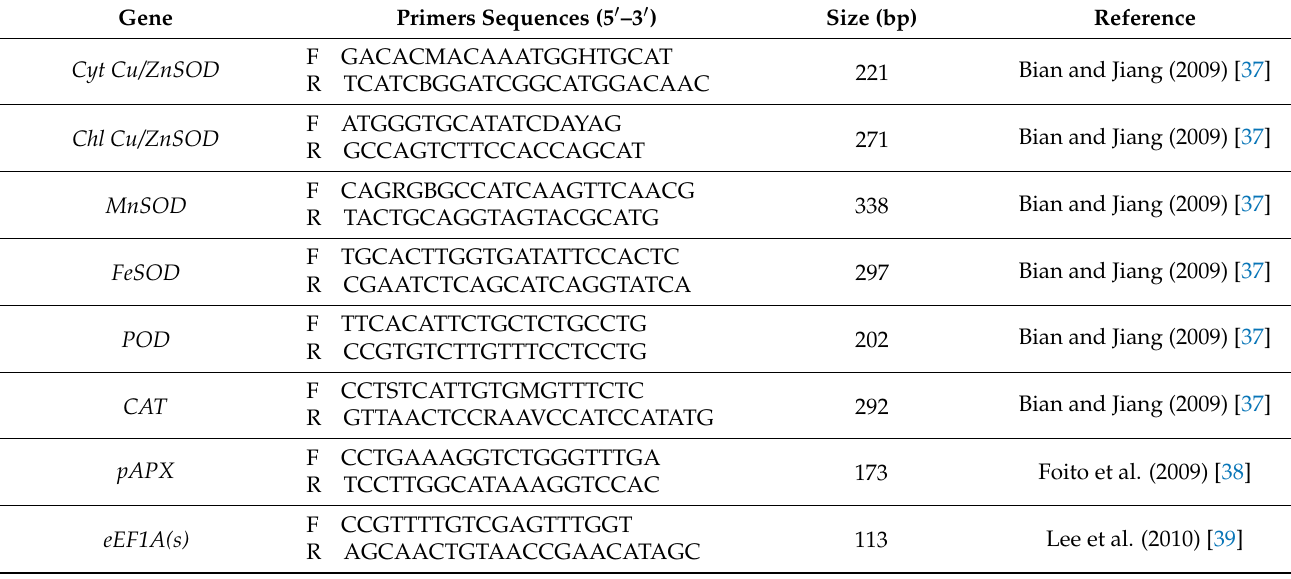
Table 1. Primer sequences used for RT-qPCR analyses in this study. Gene Primers Sequences (5 (cid:48) –3 (cid:48) ) Size